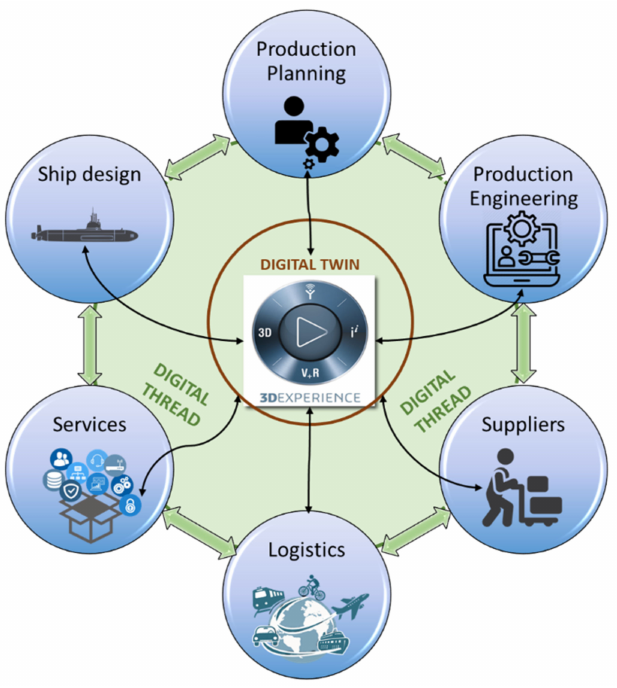
Figure 11. Digital Twin and thread implementation scheme for a